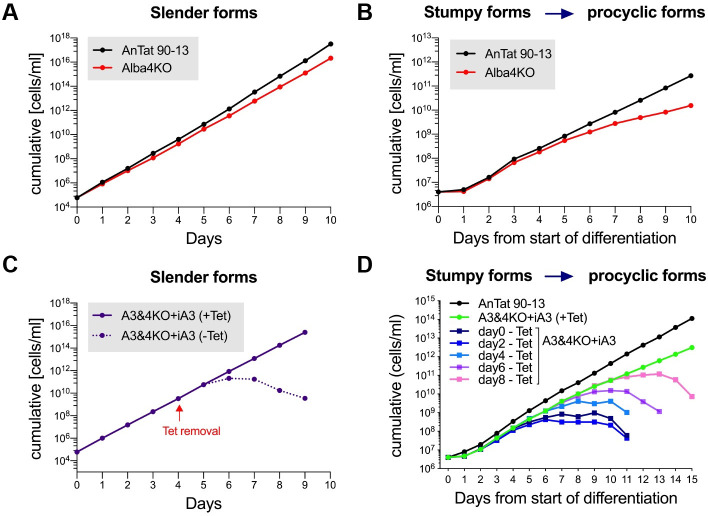
Partial redundancy of Alba3 and Alba4.(A) Cumulative growth curves of AnTat 90–13 & Alba4KO bloodstream forms (n = 3). Error bars, mean ±SD. (B) Cumulative growth curves of AnTat 90–13 and Alba4KO during differentiation. Cells were counted daily and diluted to 4x106 ml-1 if required. (C) Cumulative growth curves of Alba3&4 knockout + inducible Alba3 expression cell line (A3&4KO+iA3). Growth of A3&4KO+iA3 bloodstream forms was monitored in the presence of tetracycline (+Tet; induces Alba3 expression) or upon removal of tetracycline (-Tet). (D) Cumulative growth curves of A3&4KO+iA3 cells during differentiation. A3&4KO+iA3 slender forms were cultured and allowed to differentiate to stumpy forms in the presence of tetracycline (+Tet). Thereafter, tetracycline was removed at different time points from the start of differentiation. Cells were counted daily and diluted to 4x106 ml-1 if required.